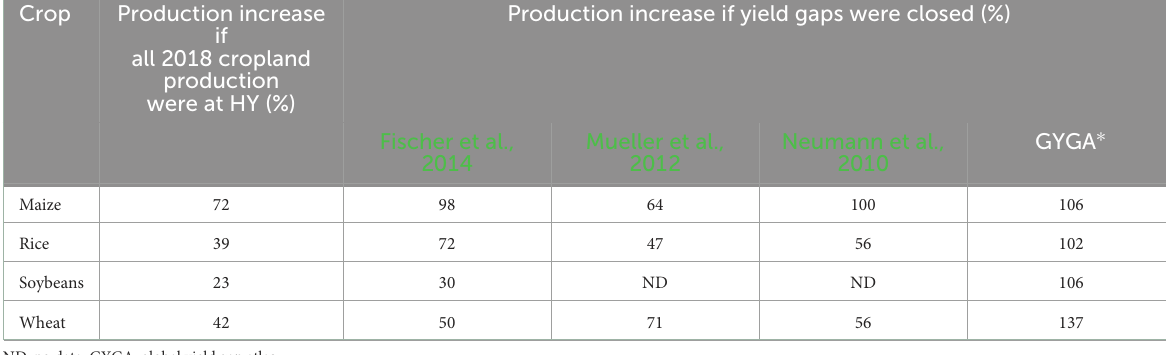
TABLE 4 Comparison of potential increase in production of specific crops calculated by differing sources using various methodologies. Crop